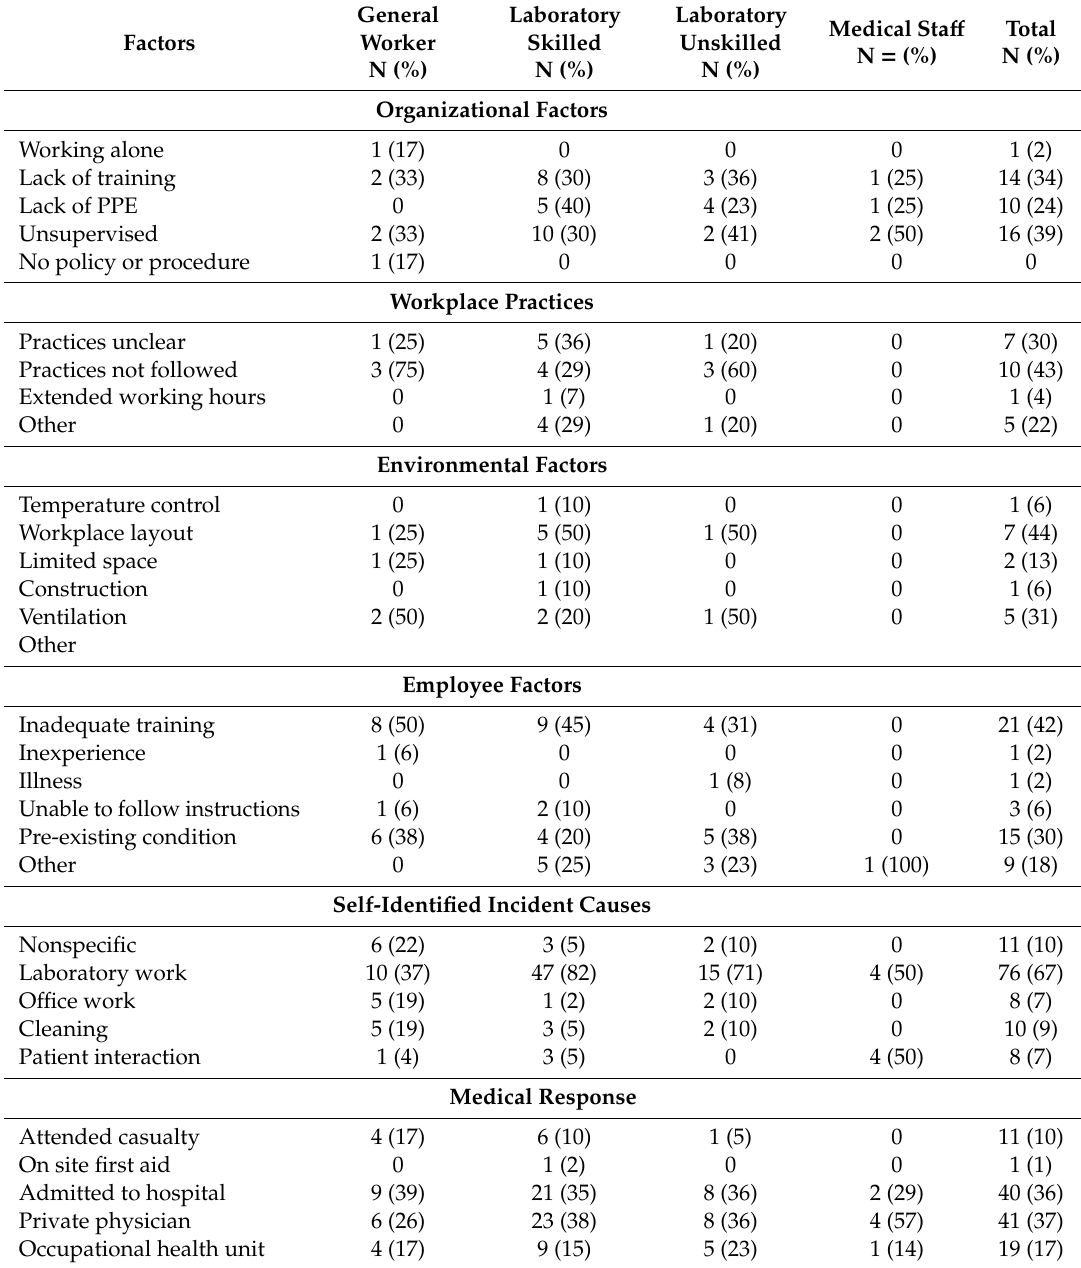
Table 3. Factors a ff ecting the incidence of TB